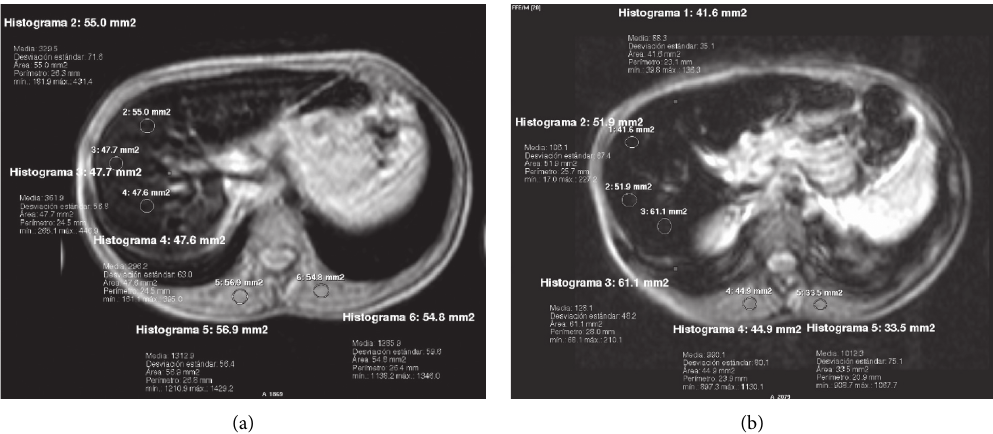
Figure 1: Abdominal MRI of patient. (a) Proton density fast field echo (PD FFE) sequence and (b) relaxation time T2 FFE sequence in the same axial section, with 3 regions of interest (ROI) in the liver and 2 ROIs in the paravertebral musculature to perform.